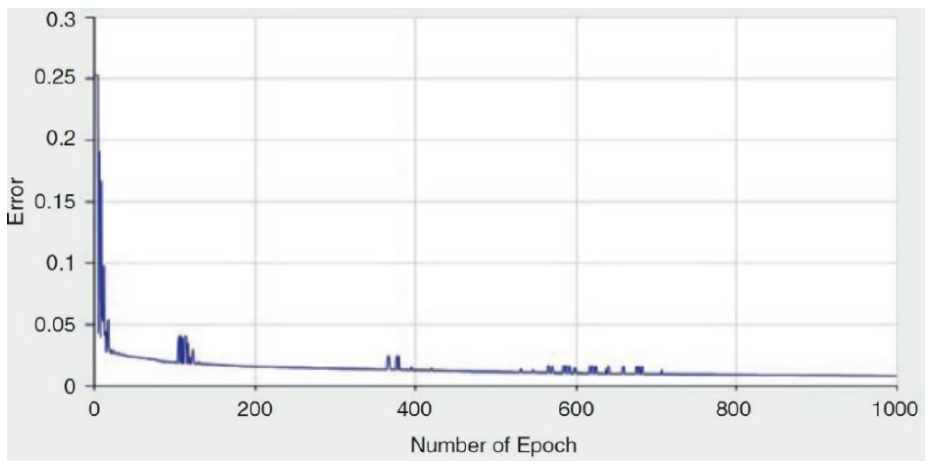
Figure 5. Training curve of the ANN model using a combination of 17 different input layers (from [6]).